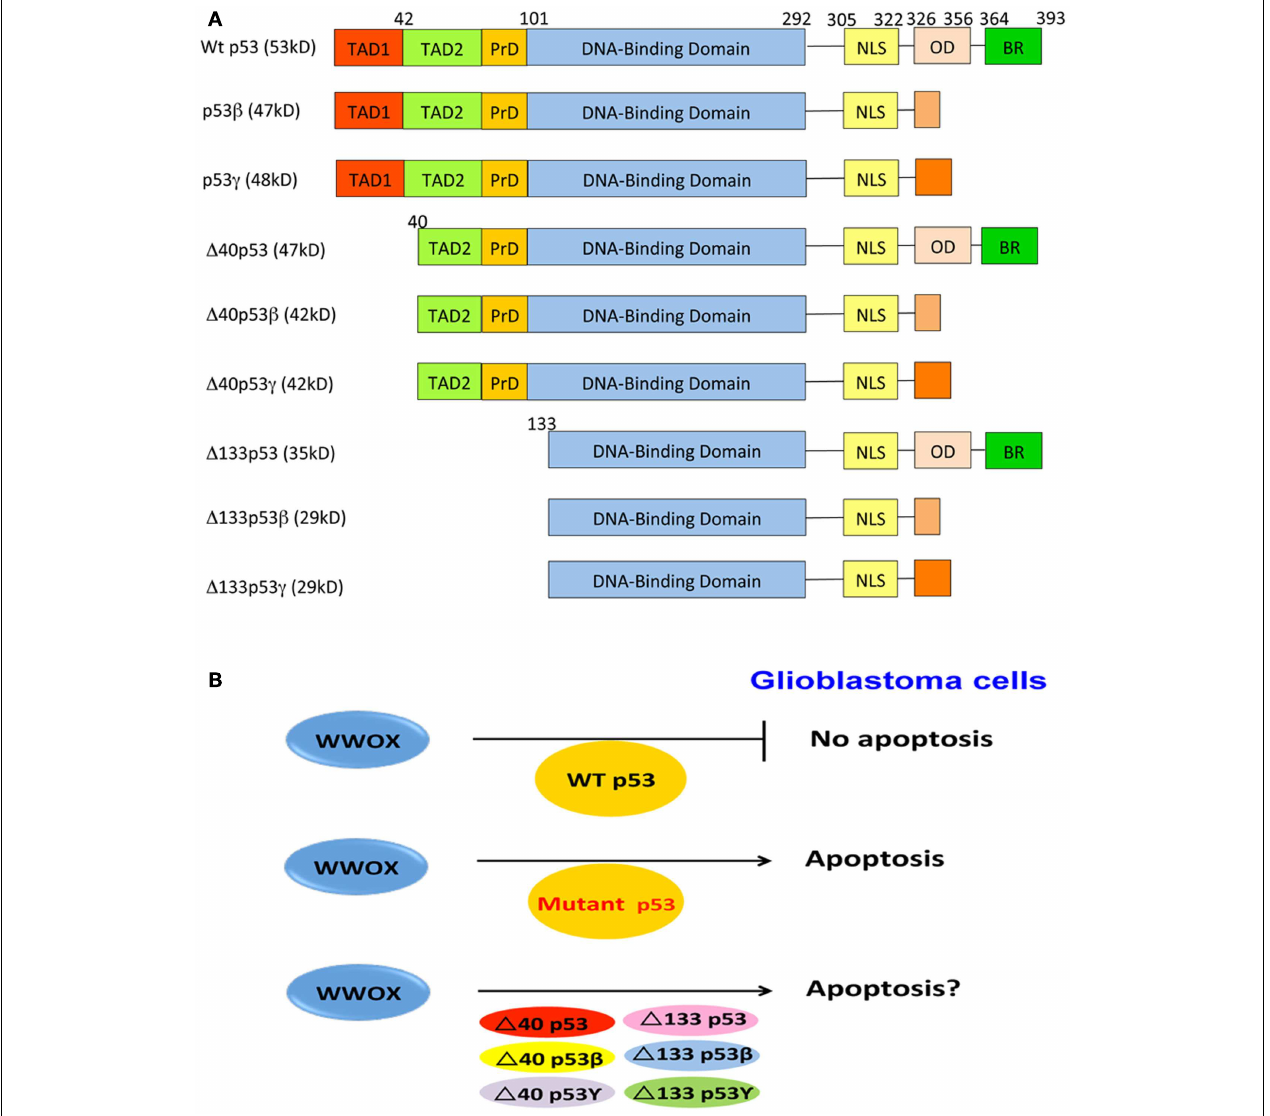
FIGURE 2 | p53 andWWOX in GBM cell apoptosis. (A) Full-length p53 possesses two N -terminal transactivation acidic domains, a proline-rich domain, a central DNA-binding region, and a C -terminal domain, containing a nuclear localization signal, an oligomerization domain, and a basic region. N -terminal deletion mutants of p53 are also shown. (B) Three likely scenarios are proposed forWWOX and p53 to regulate GBM cell death. First, ectopic WWOX fails to induce apoptosis of GBM cells expressing endogenous wild type p53. It appears that ectopicWWOX binds and functionally antagonizes